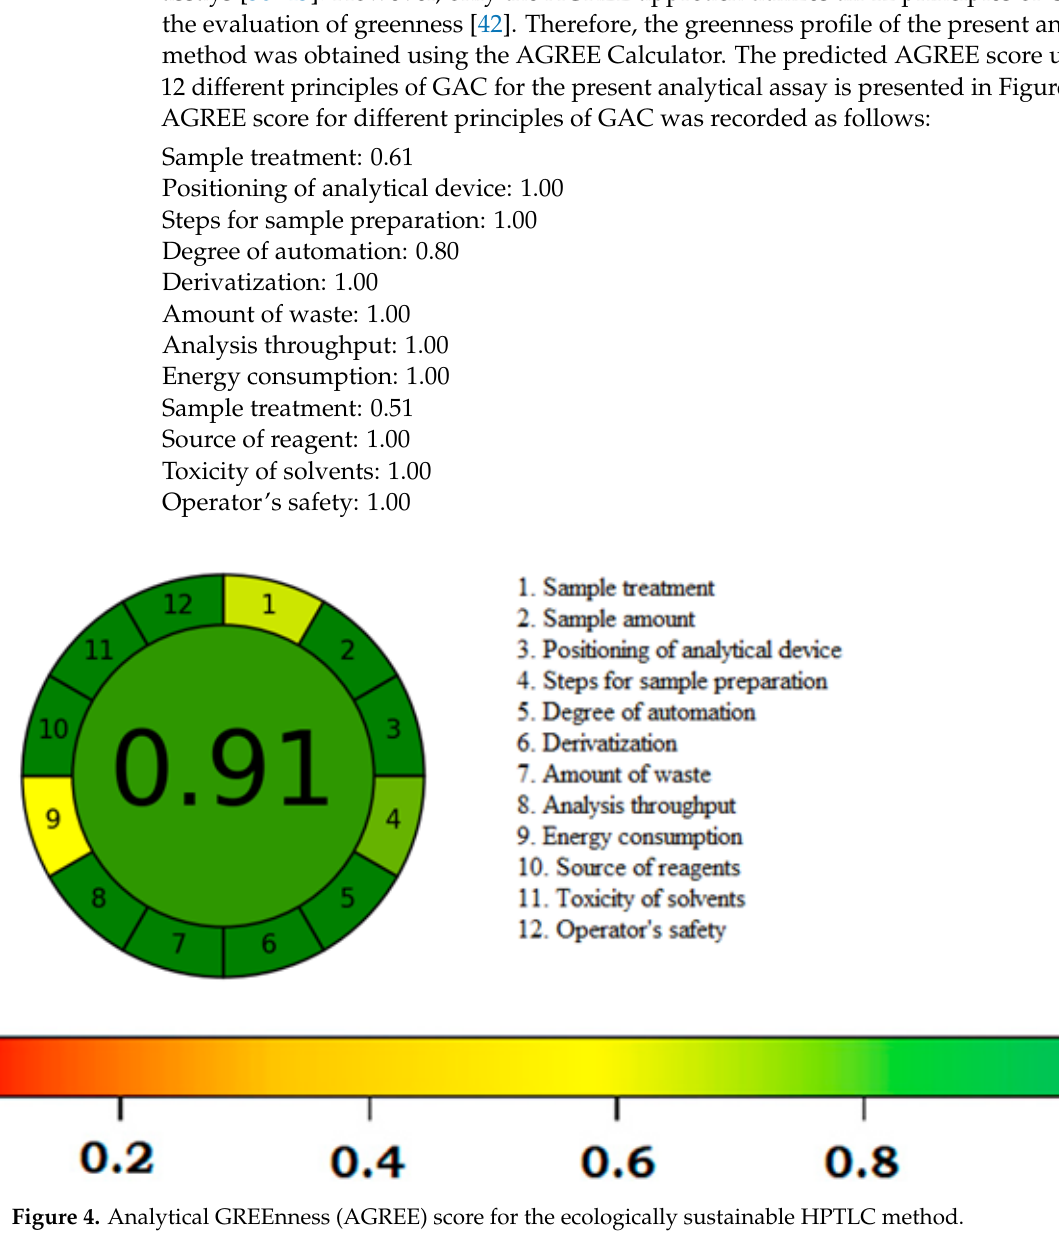
Figure 4. Analytical GREEnness (AGREE) score for the ecologically sustainable HPTLC method.